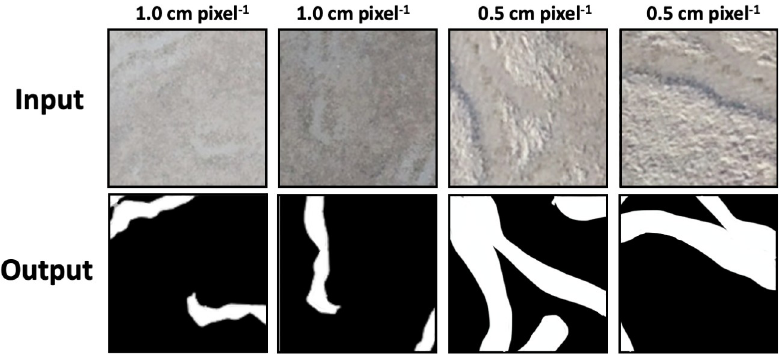
Fig 4. Examples of the training data. Upper insets show the input images and the lower insets show the output